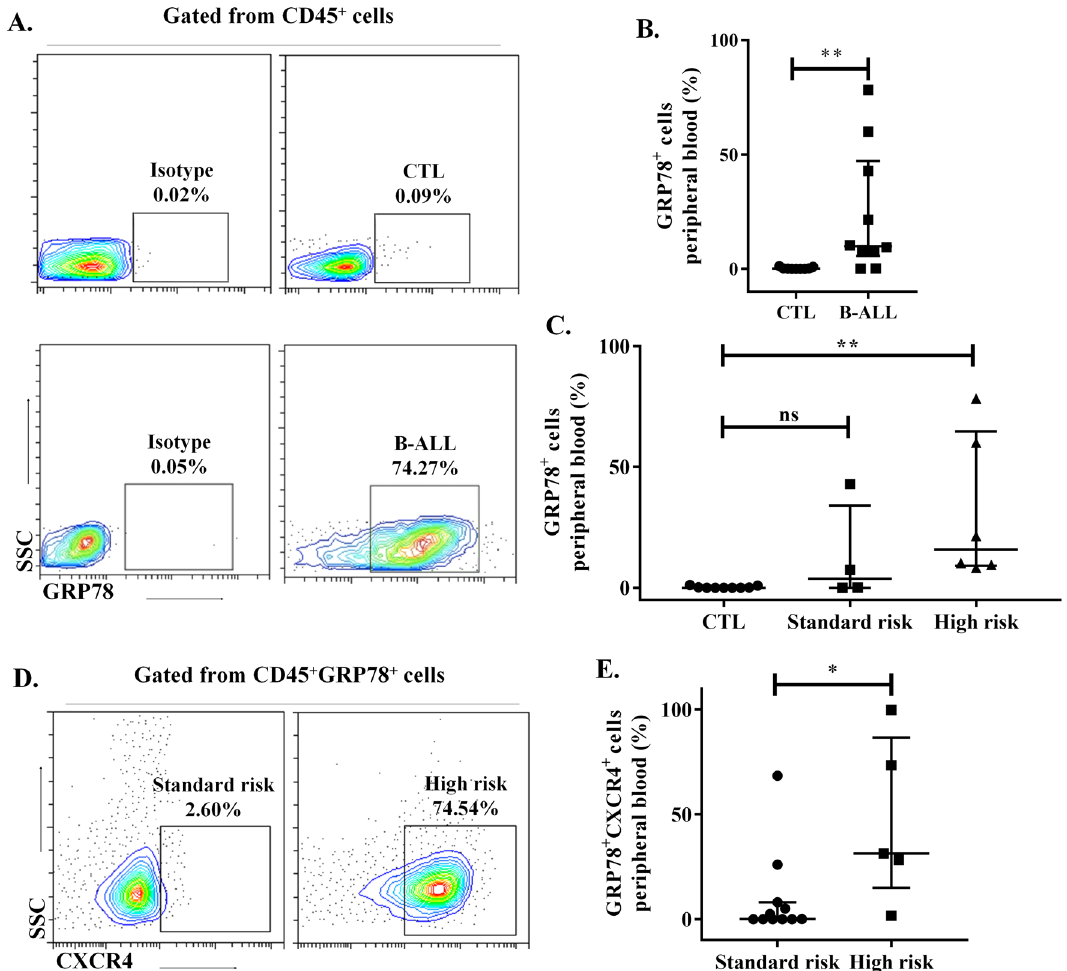
Figure 4. sGRP78 + CXCR4 + cells are present in peripheral blood of pediatric individuals with newly diagnosed B-ALL. ( A ) Live cells from peripheral blood of B-ALL patients and controls (CTL) were stained with anti-CD45 and anti-GRP78. ( B ) Statistical representation of GRP78 + cells in B-ALL patients and controls. ( C ) Percentages of GRP78 + cells in high and standard risk are depicted. ( D ) Live cells from peripheral blood were stained with anti-CD45, anti-GRP78 and anti-CXCR4. The plots of a Standard risk patient (left) and High risk patient (right) are depicted. ( E ) Percentages of sGRP78 + CXCR4 + cells in high and standard risk in peripheral blood. Data are the medians plus ranks. Statistical analysis was performed by two-tailed Mann–Whitney U test, **p < 0.01, ***p < Analysis of sGRP78 + leukemia cells in a xenotransplantation model. Since we observed the pres- ence of sGRP78 + CXCR4 + double positive cells in high-risk leukemia samples, both in bone marrow and periph- eral blood, we wondered whether purified sGRP78 + cells could be ready to migrate and disseminate. Since whole leukemia cells were capable to infiltrate bone marrow and lymph nodes in nude mice (Supplementary Fig. 3); we subcutaneously injected purified High-risk patient-derived sGRP78 + leukemia cells (Fig. 5A) and, 3 weeks upon transplantation we detected living CD45 + human cells from bone marrow and lymph nodes expressing sGRP78, CXCR4 and CD34 (Fig. 5B–D). Around 80% of human recovered cells expressed sGRP78, both in bone in mar- row and lymph node (Fig. 5E,G). Also, we recovered up to 30,000 human sGRP78 + cells in the best-case scenario (Fig. 5F,H). Compared to lymph nodes, the percentage of CXCR4 + cells were higher in bone marrow while the percentage of CD34 + cells were lower in this tissue (Fig. 5E,G). Our data suggest that sGRP78 + leukemia cells can migrate and lodge different tissues, and that some cells are able to maintain surface markers associated to the leukemic cell phenotype.